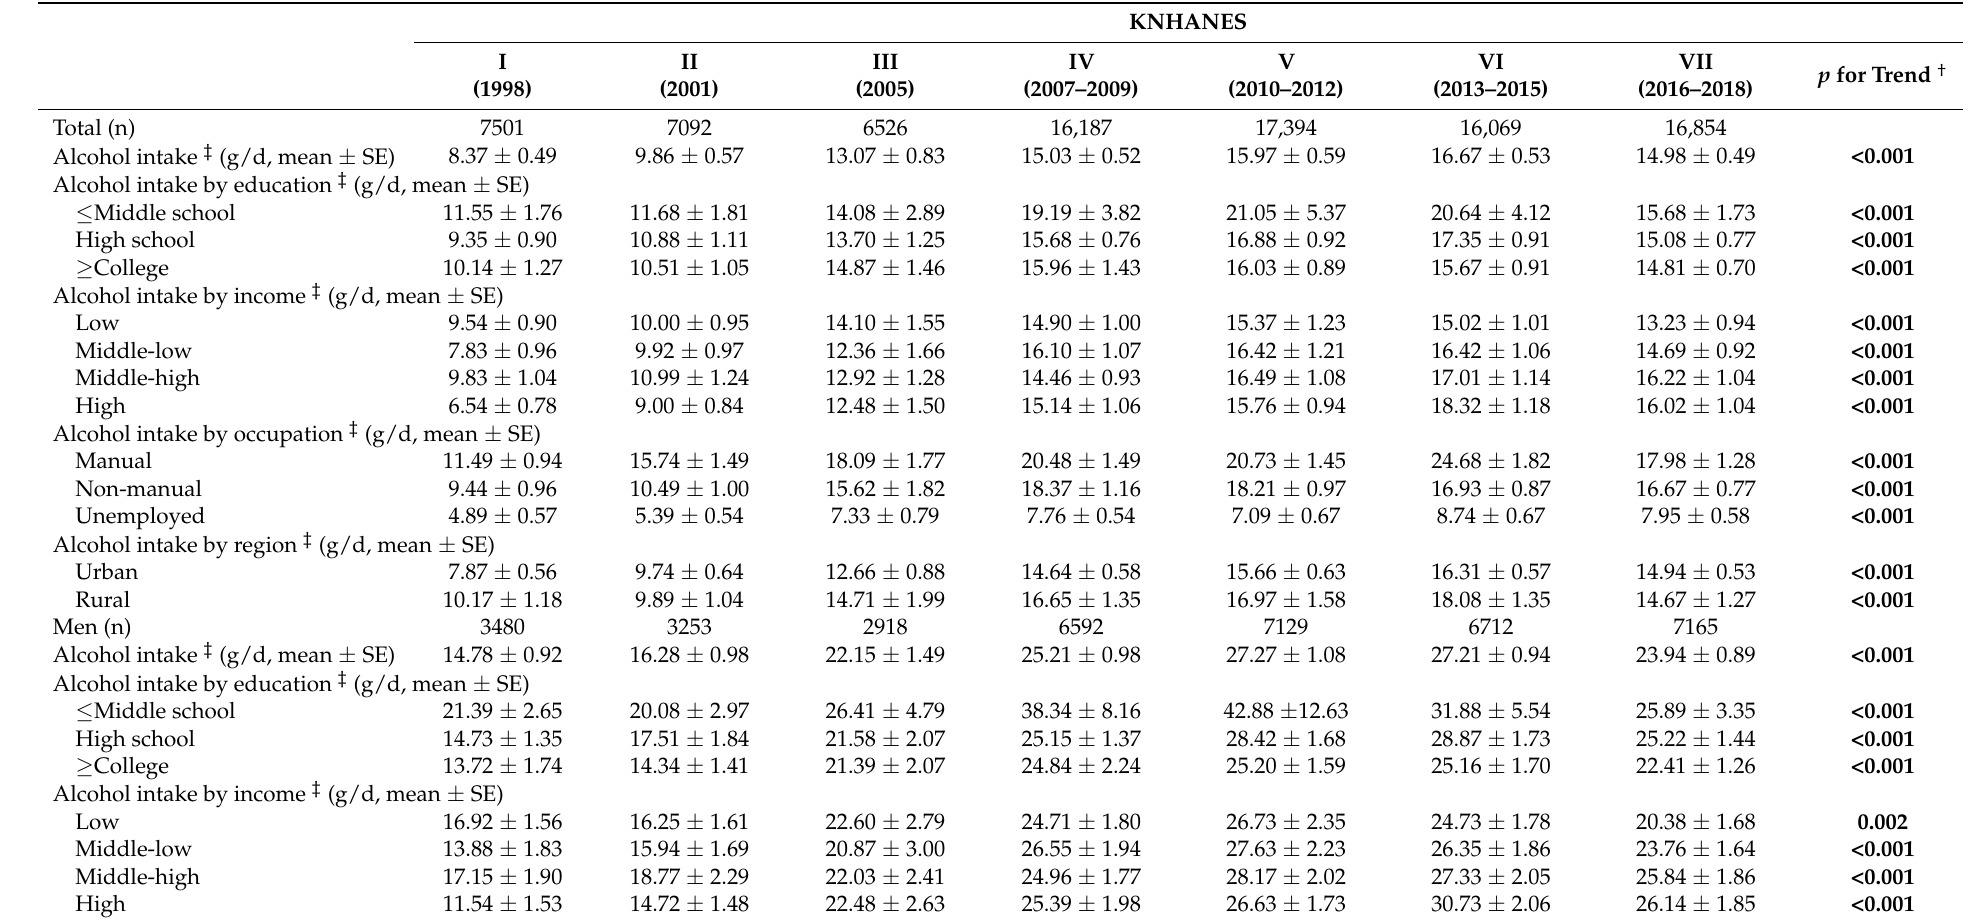
Table 2. Trends in daily consumption of pure alcohol for Korean adults aged ≥ 19 years from 1998 to 2018 using the Korea National Health and Nutrition Examination Survey